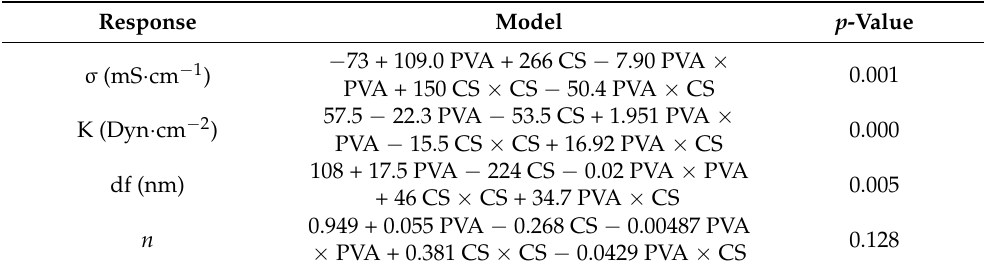
Table 2. Models fitted to experimental data of electrical conductivity ( σ ), consistency index (K), fiber size (nm), and flow index ( n ) and its statistical significance ( p -value).